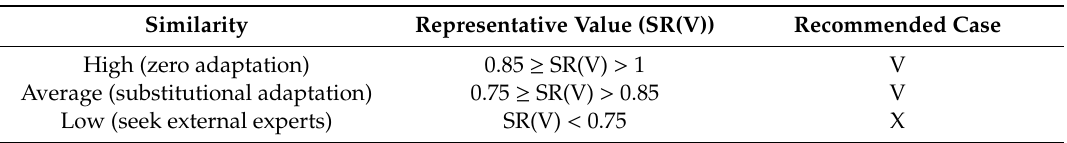
Table 3. Case similarity.